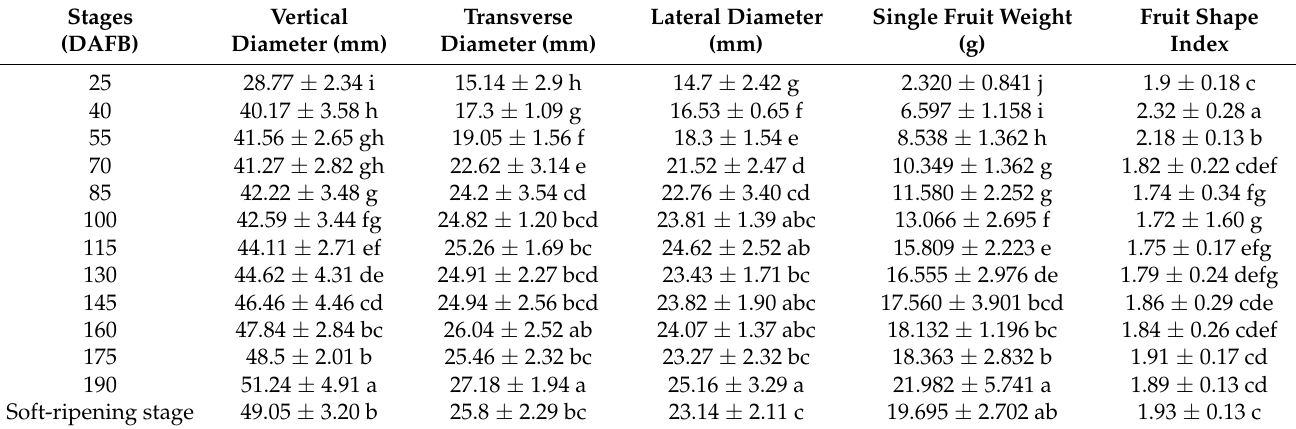
Table 2. Dynamic changes of fruit appearance quality-related indexes of A. eriantha ‘Ganlv